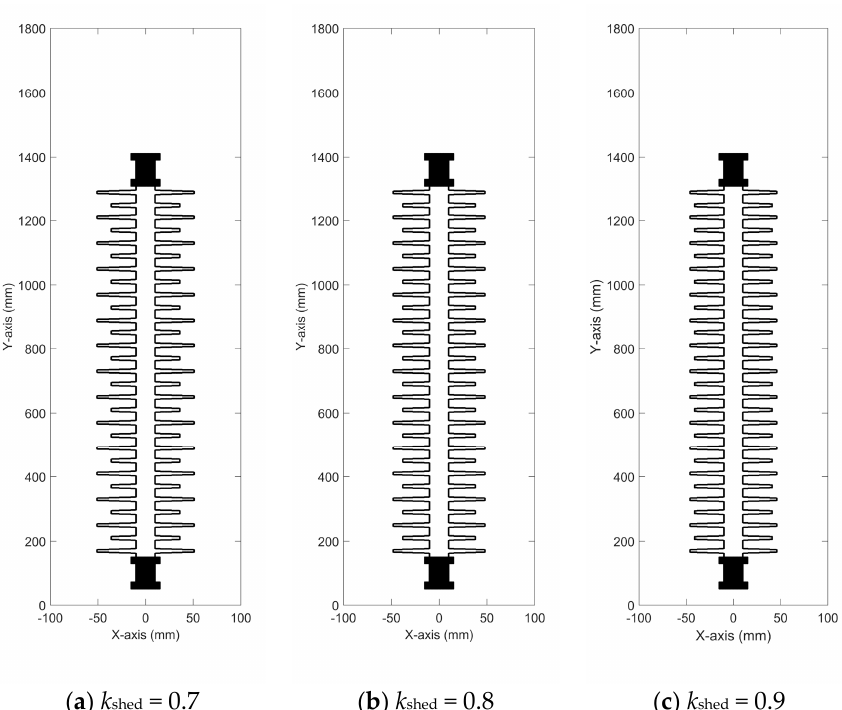
Figure 17. Insulator geometry with different alternative shed ratios ( CF = 3.0 and θ = 10°).